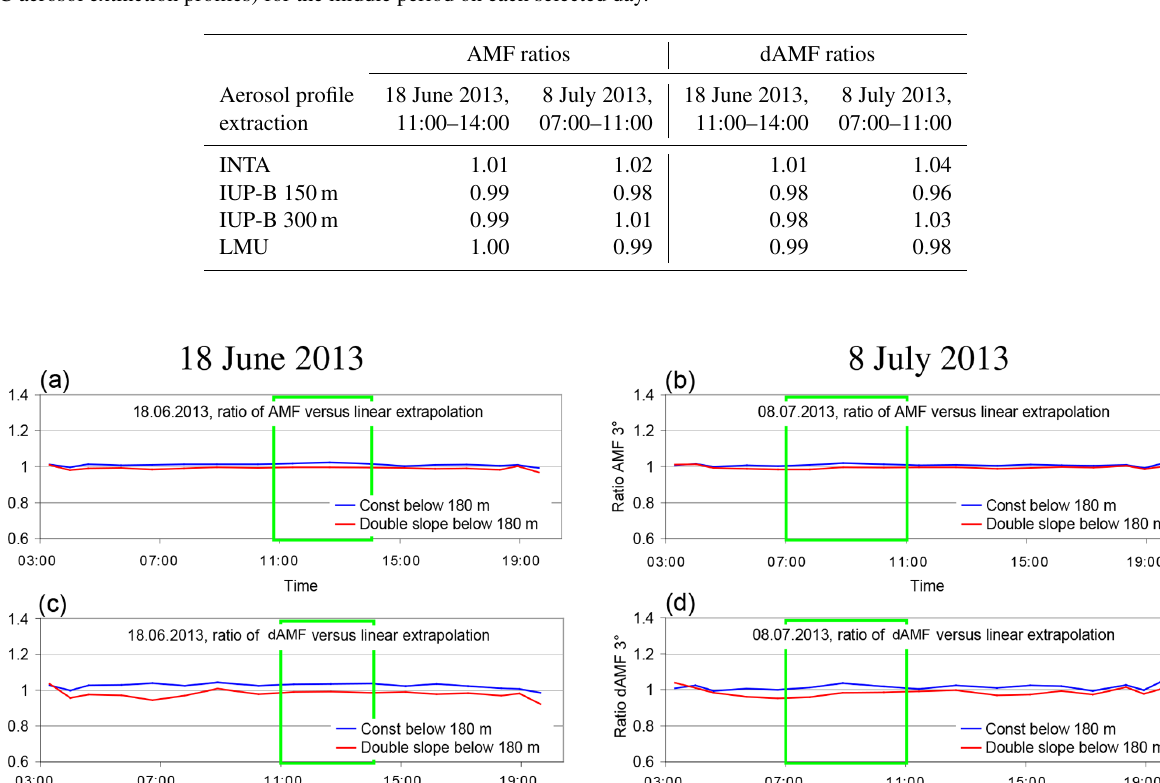
Table A5. Average ratios of O 4 (d)AMFs simulated for different aerosol extinction profiles vs. the results for the standard settings (using the MPIC aerosol extinction profiles) for the middle period on each selected day.